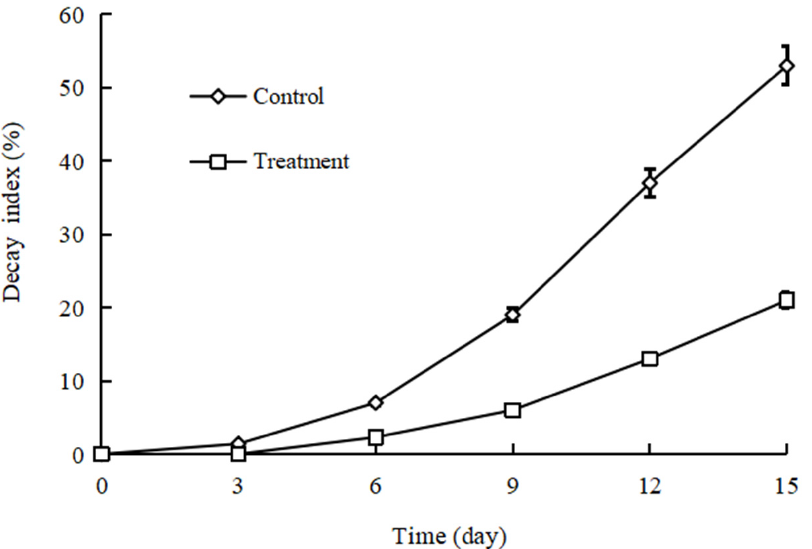
Figure 2. Effect of pullulan-based coatings on the decay index of cowpeas during refrigerated storage. Bars represent the standard deviation ( n = 6).